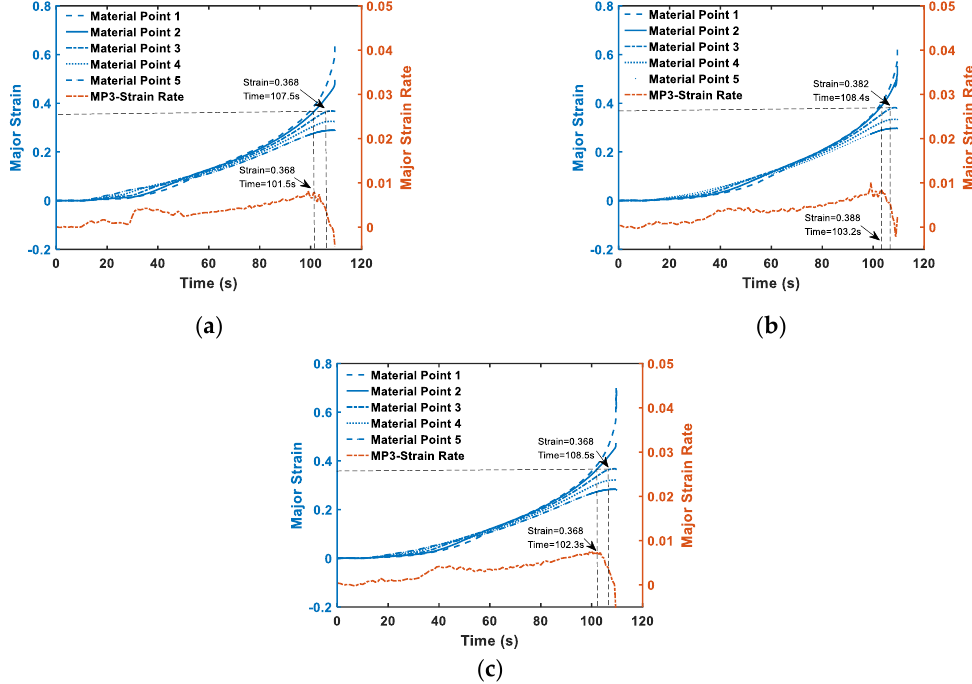
Figure 9. Major strain and strain rate evolution for the third test: ( a ) section a; ( b ) section b; ( c ) section c.